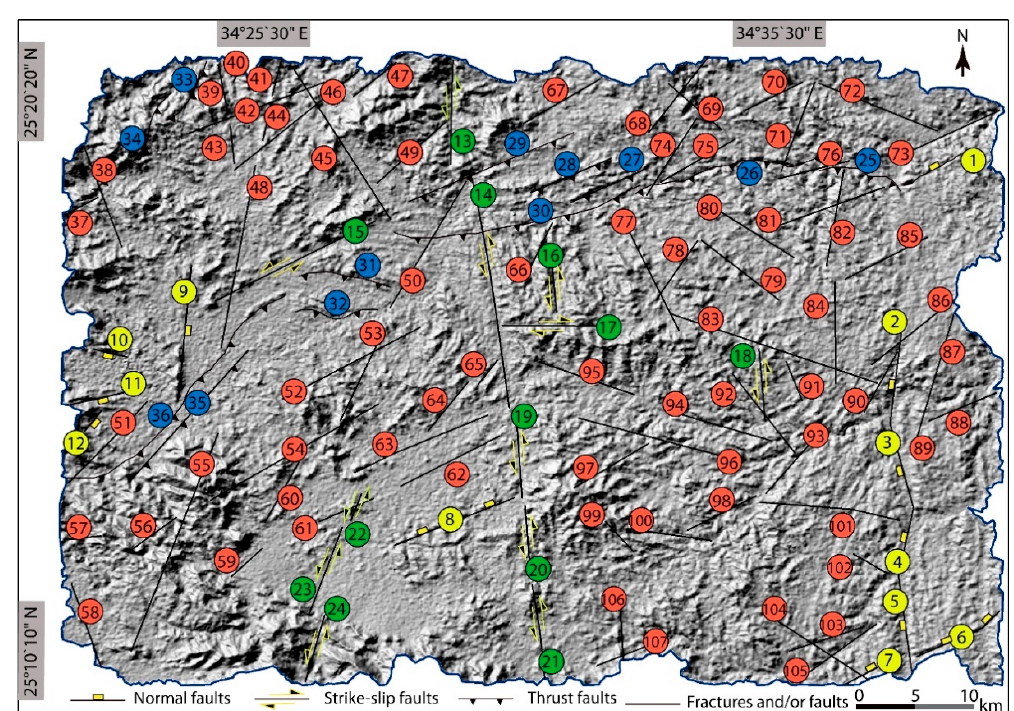
Figure 6. Locations and reference numbers of S mf index for 107 identified mountain front segments. Mountain front sinuosity was calculated along every segment of the study area.